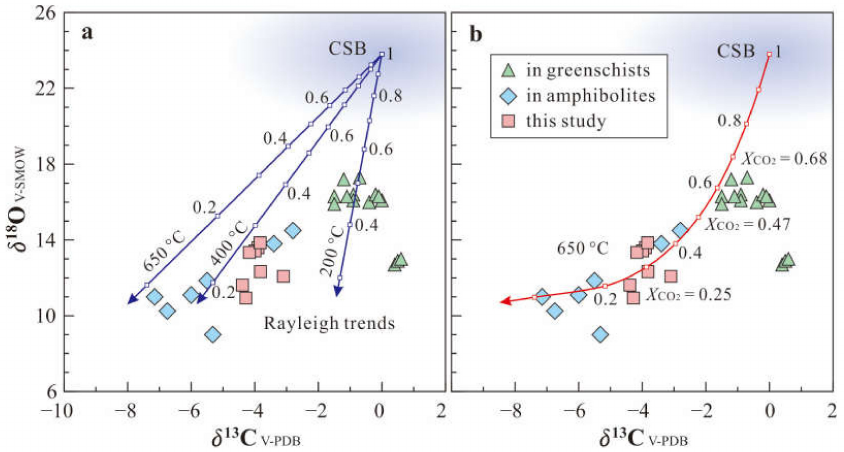
Figure 7. The δ 18 O– δ 13 C variation diagrams for vein carbonates in metabasites of greenschist facies and amphibolite facies, which represent the δ 18 O– δ 13 C values of metamorphic fluids in each metamorphic facies. The δ 18 O– δ 13 C data of dolomite from the chlorite schist in this study and in previous literature [67] are plotted for comparison. The modelled δ 18 O– δ 13 C evolving trends of fluids produced in Rayleigh fractionating decarbonation processes are also shown, without ( a ) or with ( b ) the contribution of dehydration. Calibrations along the curves represent the fraction of carbonate that remained in solid phases. The δ 18 O– δ 13 C data were collected from [5,98,109,110]. The δ 18 O of H 2 O released from metabasalt adopted here is ~9.5‰ [111]. CSB: carbonated seafloor